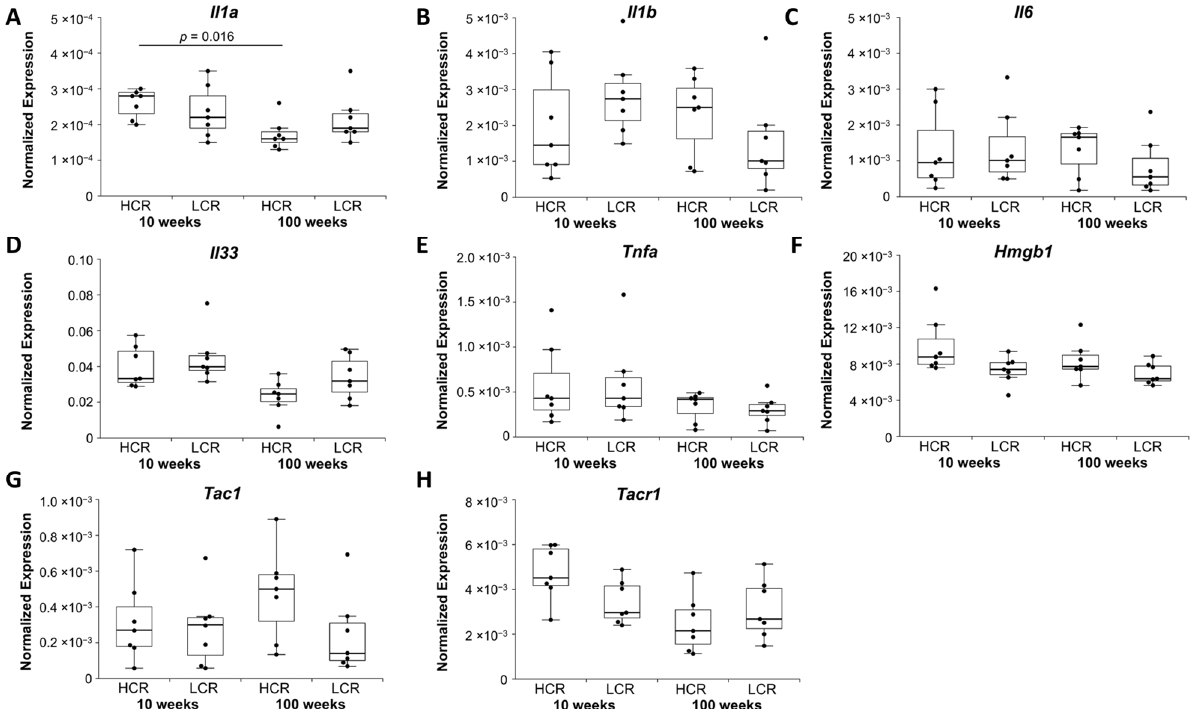
Figure 5. Normalized expression (NE) of ( A – D ) interleukins Il6, Il1b, Il33, Il1a, ( E ) tumor necrosis factor alpha, ( F ) high mobility group protein box 1 protein (Hmgb1) , and ( G ) synthase and ( H ) receptor of substance P. qRT-PCR data were normalized to the expression of the house keeping gene Rps18 . Results are shown as box plots with individual data points. Significant differences between two groups are marked as a line spanning between them with the p -value displayed above. p ≤ 0.05 was considered statistically significant.